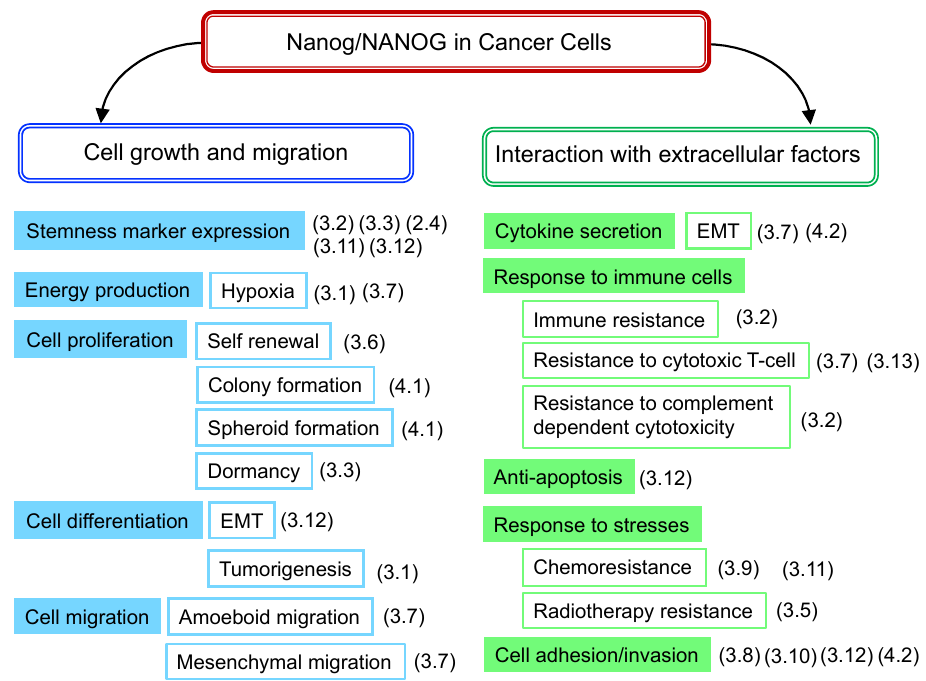
Figure 2. Nanog-dependent phenomena observed in cancer cells. Contents listed in Table 1 are rearranged according to the phenomena of cancer cells. (3.1), (3.2), denote the number of sub-sections with a description of the phenomenon.